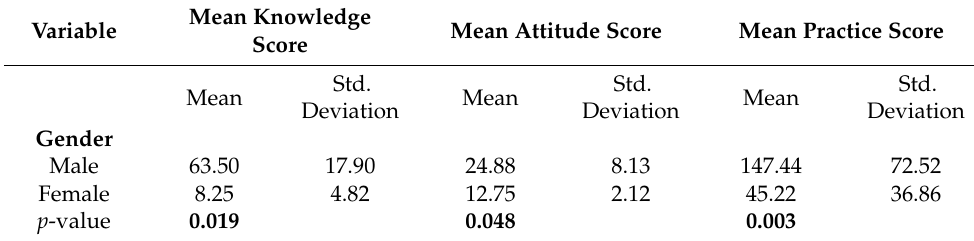
Table 5. Mean knowledge, attitude, and practice scores across socio-demographic